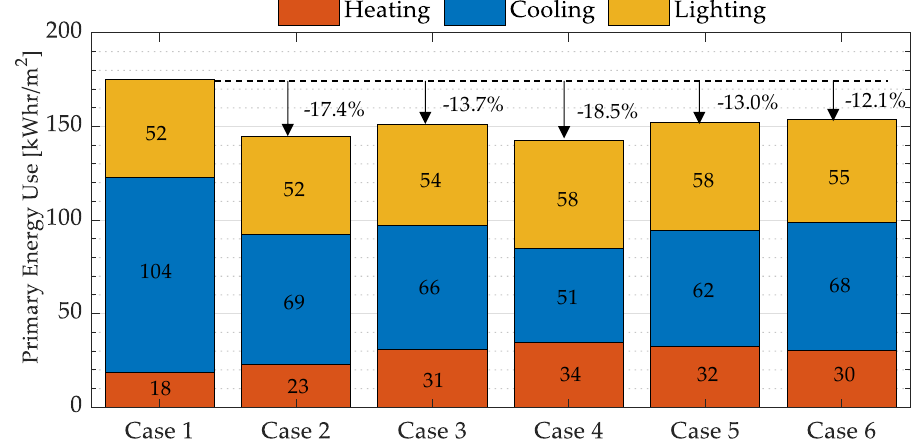
Figure 6. Total annual primary energy use for the various window system cases in Athens.